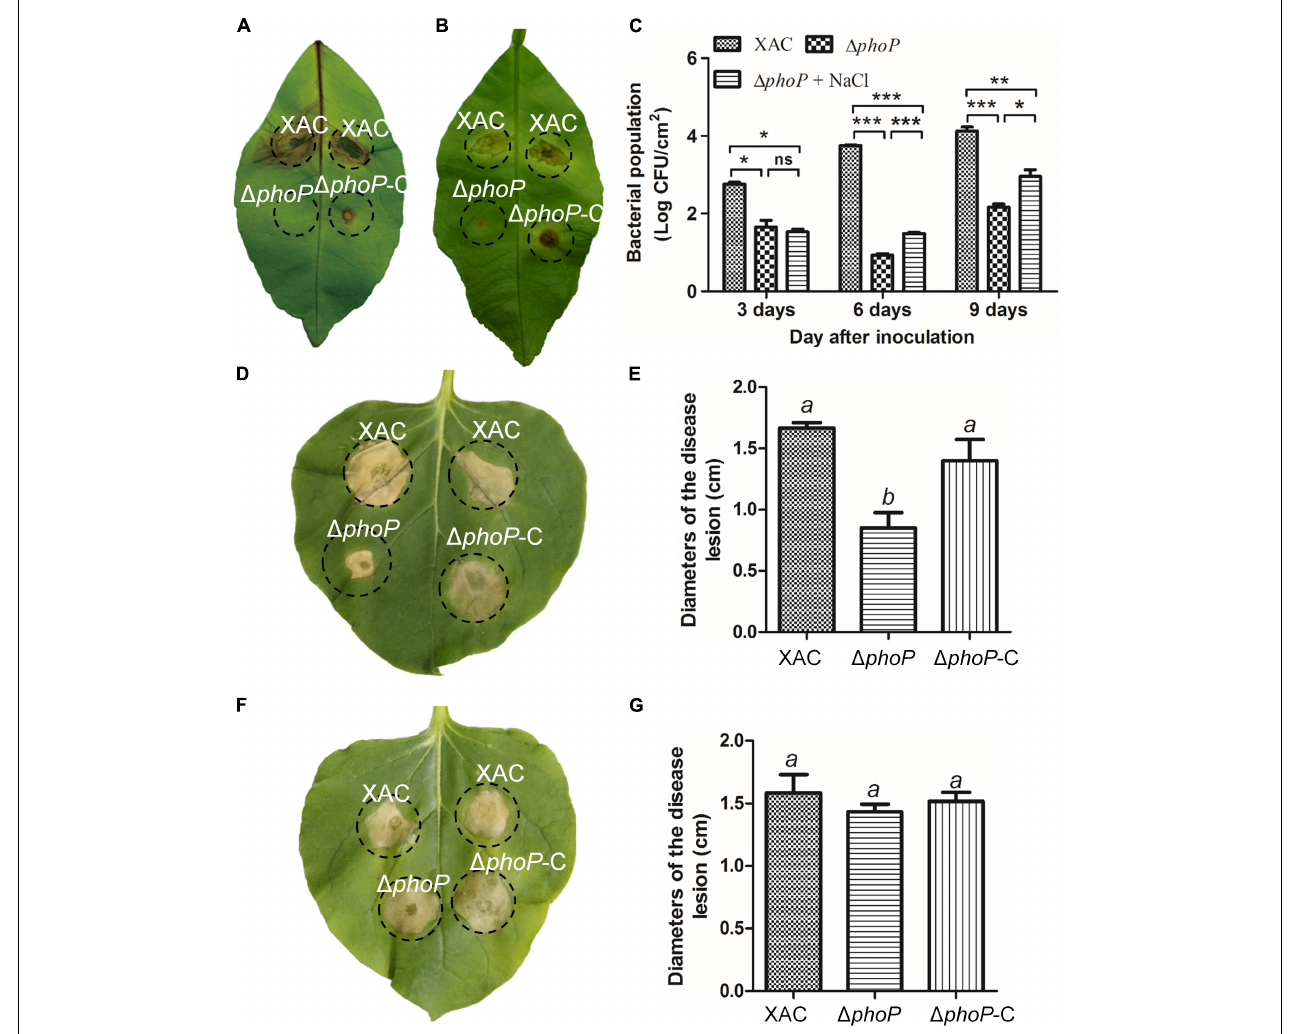
FIGURE 3 | Increase in phoP mutant virulence under low osmostress. (A) Citrus leaves infiltrated with bacterial suspension [5 × 10 8 colony-forming units (CFU)/mL]. (B) Citrus leaves infiltrated with bacterial suspension [5 × 10 8 colony-forming units (CFU)/mL] supplemented with 0.05 M NaCl. (C) Bacterial strains were injected into plant leaves using a 1 ml syringe. Bacterial colonies were isolated from leaf disks and counted by serial dilution after inoculation. Each value represents the average number of three-leaf disks. (D,E) Effects on the hypersensitive response (HR) of Nicotiana benthamiana induced by bacterial suspension. (F,G) Effects on the hypersensitive response (HR) of Nicotiana benthamiana induced by bacterial suspension supplemented with 0.05 M NaCl. Error bars, means ± standard deviations ( n = 3). * P < 0.05, ** P < 0.01, *** P < 0.001, assessed by one-way ANOVA. All experiments were repeated three times with similar